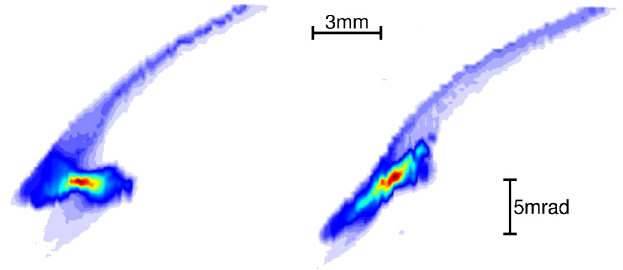
FIG. 18. (Color) Example of asymmetric phase space distribu- tion measured for 80 pC = bunch at the solenoid current of 3.7 A (left) and 3.8 A (right). The top part of the asymmetric tail was truncated during the measurement.